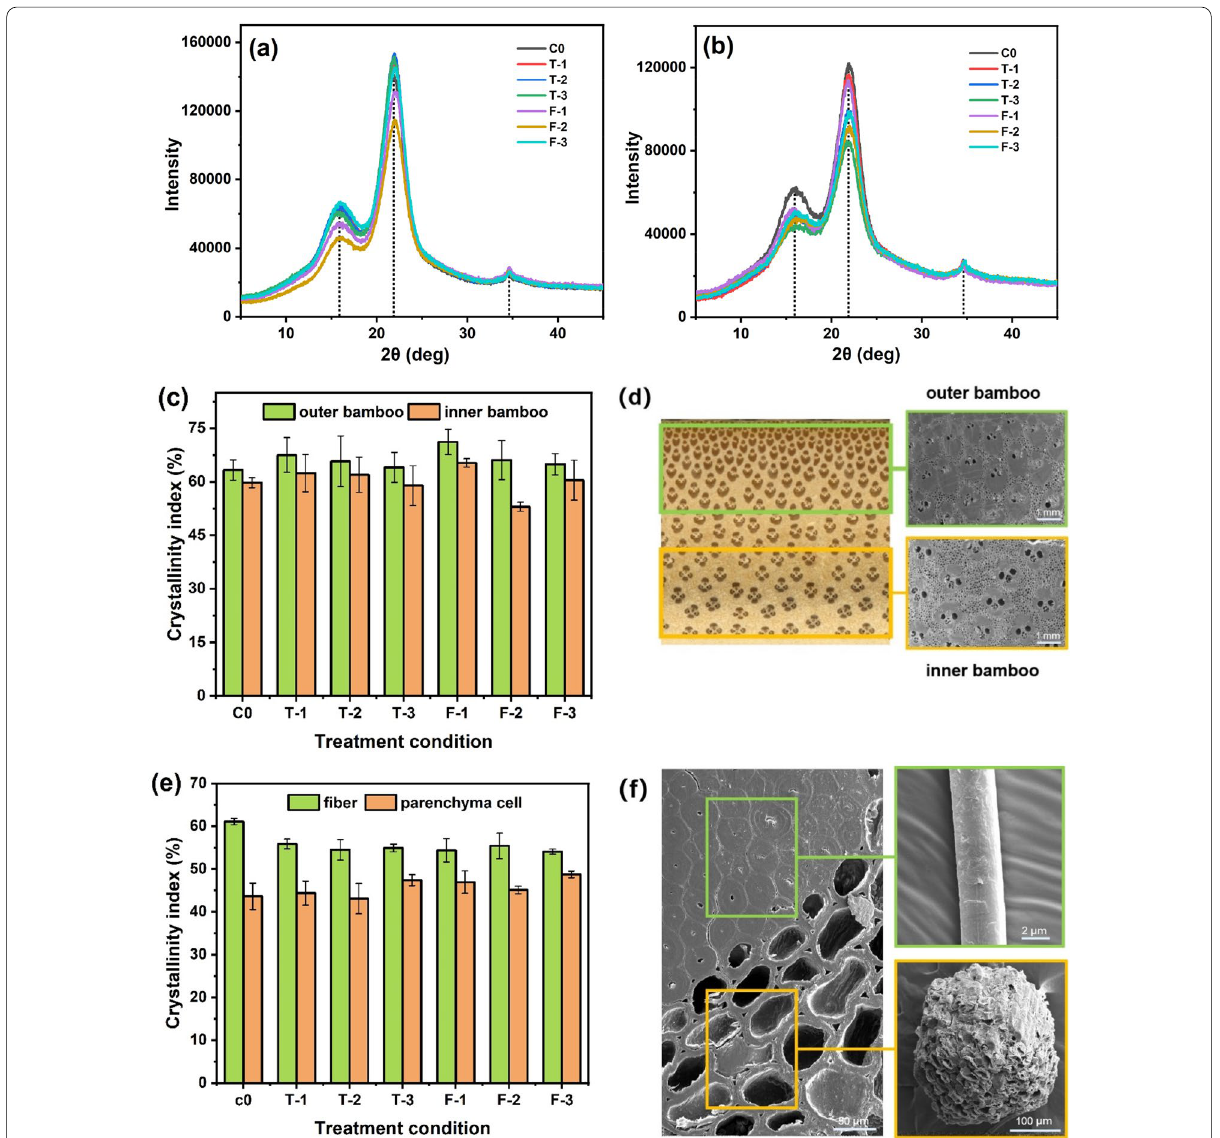
Fig. 4 XRD patterns and crystallinity index of bamboo after freeze–thaw treatment with different initial moisture content. ( a XRD patterns from the outer layer of bamboo; b XRD patterns from the inner layer of bamboo; c CrI of the outer and inner layer of bamboo; d the difference of fibers and parenchyma cells content of outer and inner bamboo; e CrI of fiber and parenchyma cell; f the microstructure of fiber and parenchyma cells from bamboo.) (The error bars refer to the standard deviation which reflects the degree of dispersion of the value relative to the